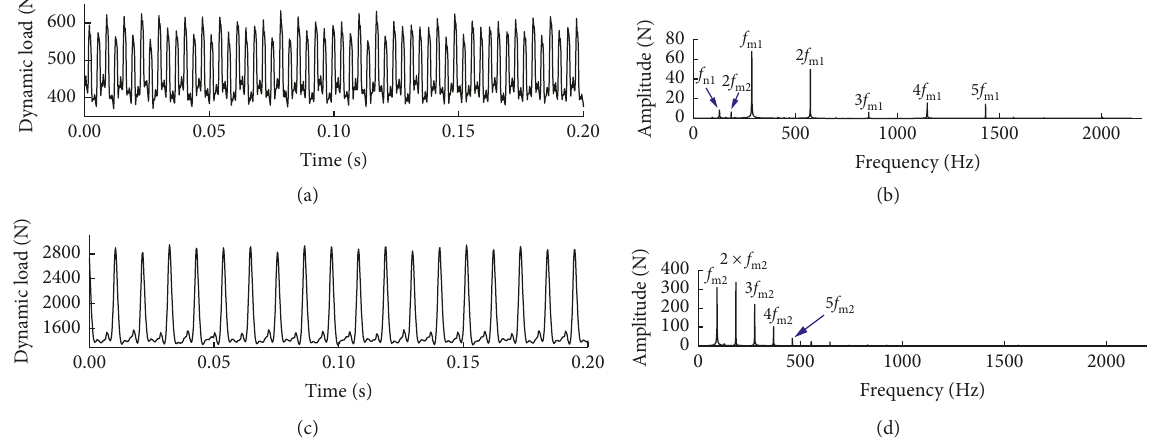
Figure 12: Dynamic load of the two-stage gear transmission system with flexible shaft. Dynamic load time history of (a) the first gear and (c) the second gear. Dynamic load spectrum history of (b) the first gear and (d) the second gear.